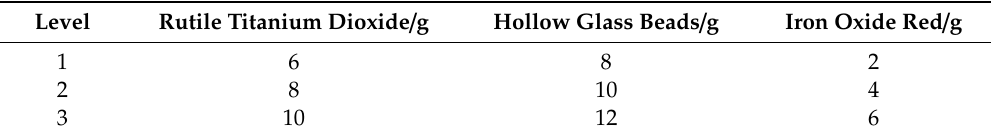
Table 1. Level table of the pigment and filler orthogonal test